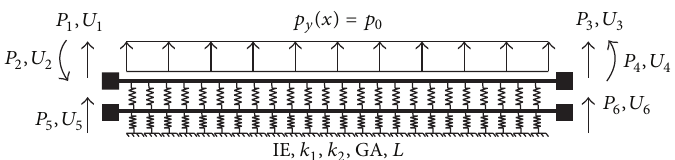
Figure 2: Natural beam element on Kerr-type